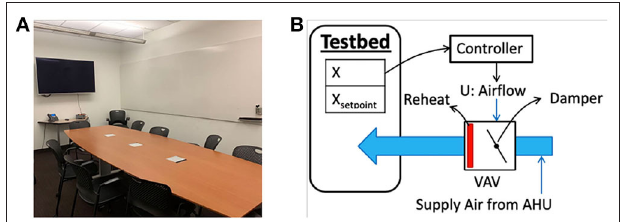
FIGURE 9 | Real-world testbed. (A) Is a photo of the conference room, and (B) Is a schematic of the VAV under control.